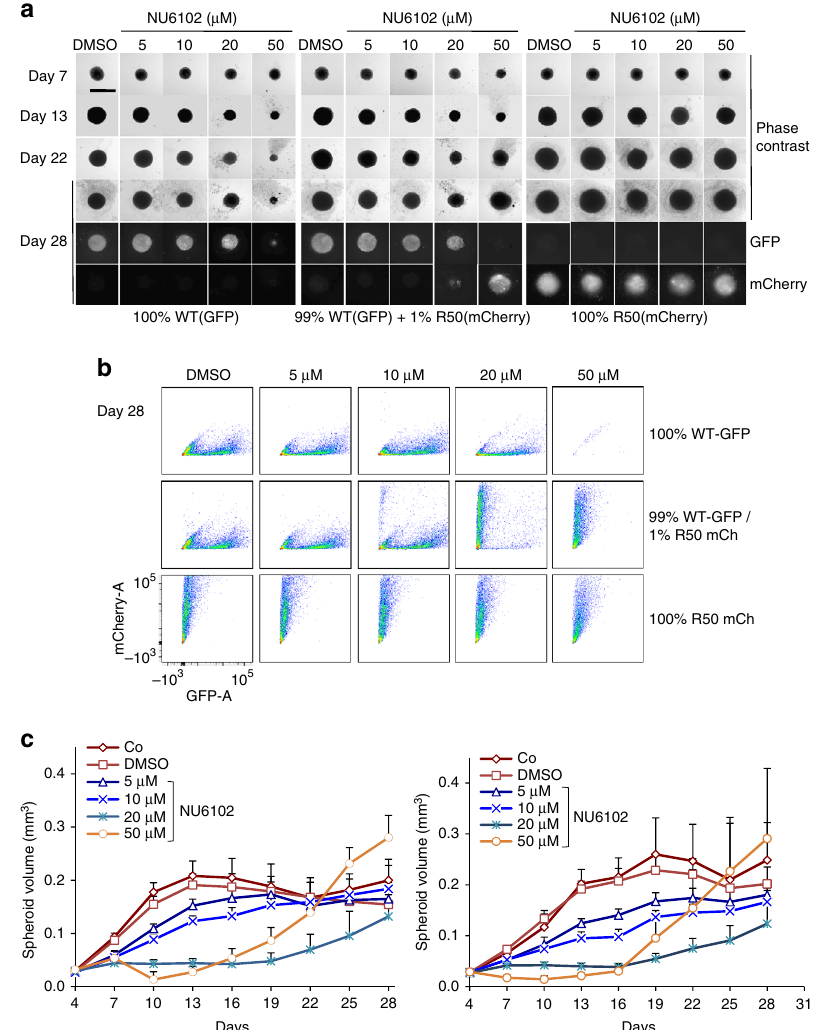
Fig. 6 Effective AT requires spatially structured tumour growth. a – c Tumour spheroids were initiated with WT-GFP+ and R50-mCh+, at different ratios (100% GFP+, 99%GFP+ / 1%mCh+, 100%mCh+), and when established, from day 4, grown either in the presence of DMSO or NU6102 at indicated concentrations. a Representative phase contrast and immuno fl uorescence images of spheroids at indicated time points. Bar, 1mm. b Flow cytometry analysis of GFP + and mCh+ cell content of spheroids at day 28 (cells of 4 – 5 spheroids per condition were dissociated and analysed). c Spheroid volume (mm 3 ) at 3-day intervals ( n ≥ 5, mean ± SD). Two independent experiments are